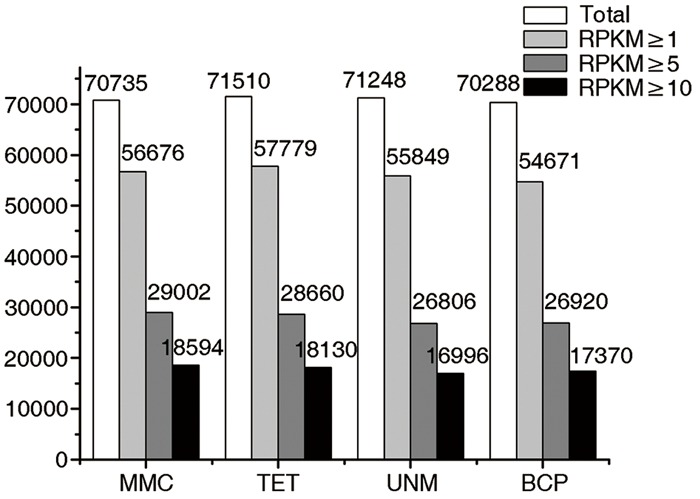
Digital gene expression (DGE) libraries of four developmental stages. The white bars in this bar graph depict the numbers of genes mapped by clean reads in each library. The light gray bars depict the numbers of genes with RPKM value ≥ 1 in each library. The dark gray bars depict the numbers of genes with RPKM value ≥ 5 in each library. The black bars depict the numbers of genes with RPKM value ≥ 10 in each library.